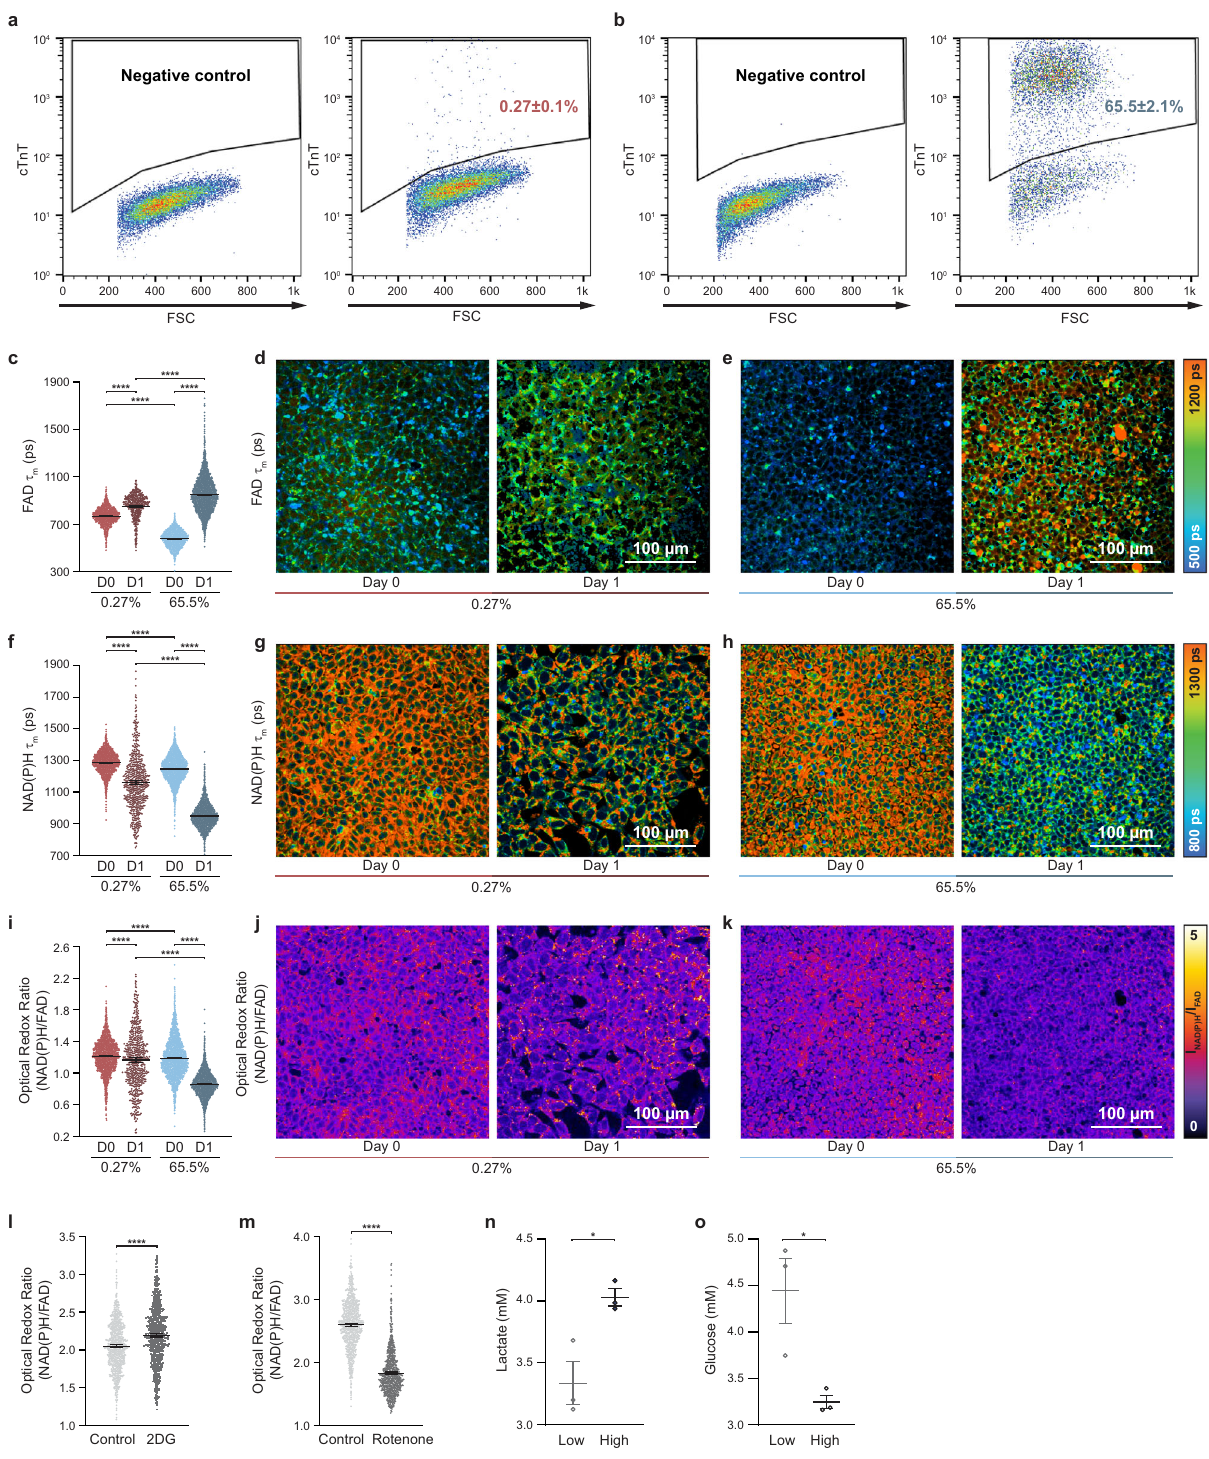
in auto fl uorescence with known metabolic inhibitors and during CM differentiation together with lactate and glucose assay results indicate that differentiating cells altered their metabolic activity 1 day after CHIR99021 treatment. This observation is consistent with previous studies that found metabolism differed between hPSCs and differentiated cells, and between cells differentiated into CMs and other cell types 34 . Overall, auto- fl uorescence imaging of NAD(P)H and FAD showed signi fi cant changes at early time points in the differentiation process,